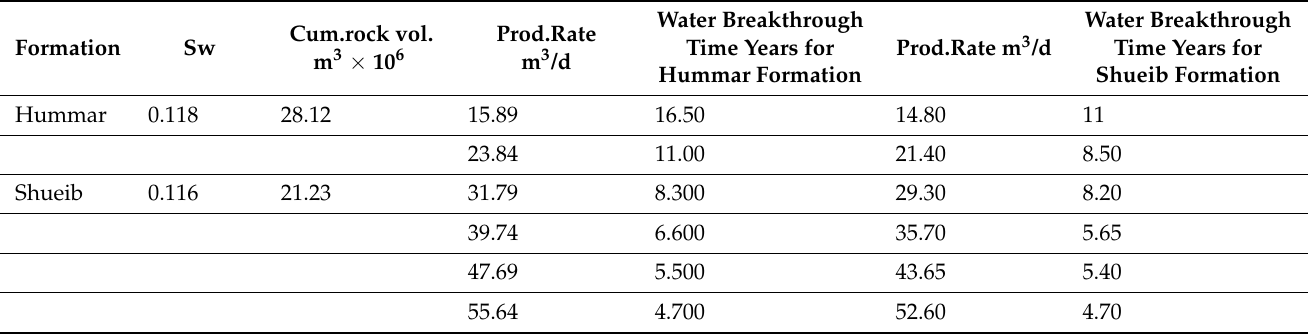
Table 12. The results of calculation for breakthrough